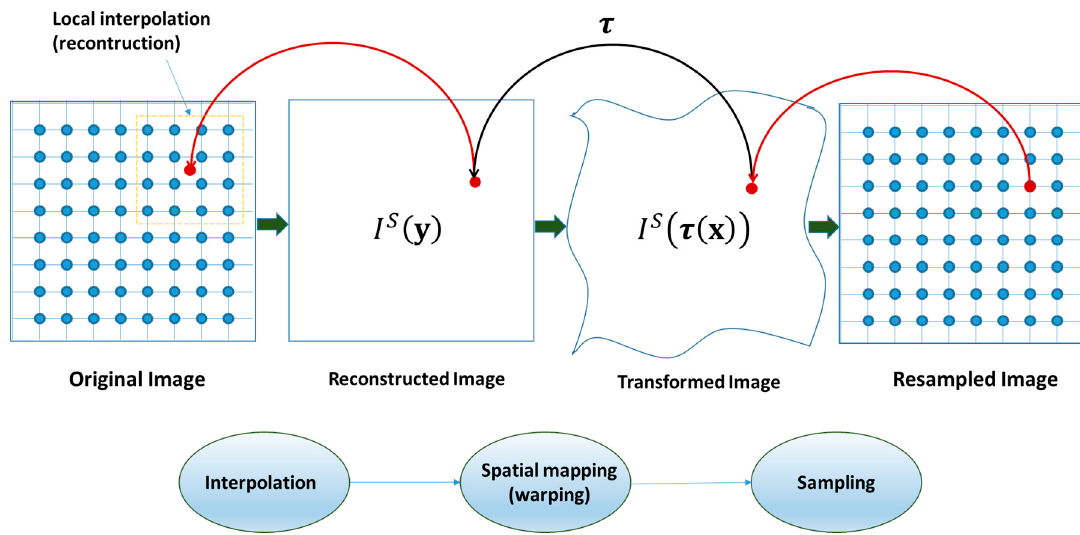
Figure 2. Conceptual scheme of finely co-registered secondary image reconstruction.